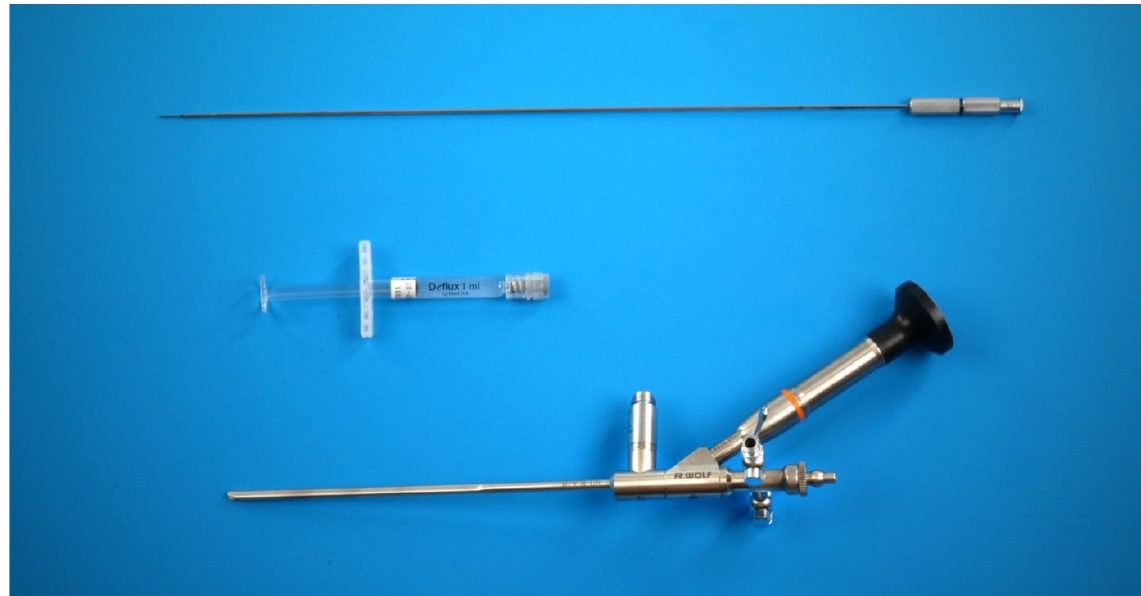
Figure 1. 9.5 Fr cystoscope with metal needle (2 sets needed).